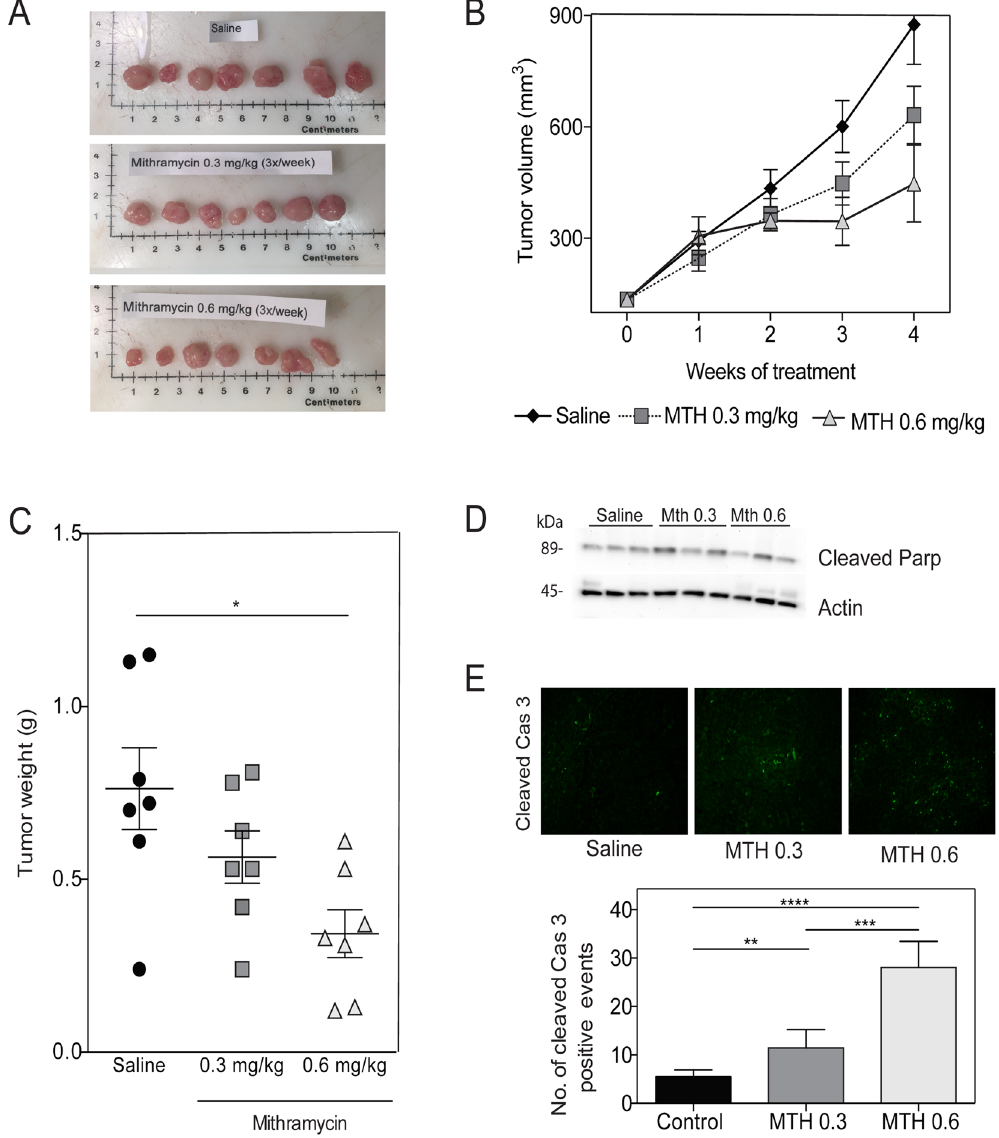
Figure 1. Sp1 downregulation causes tumor regression. MIA PaCa-2 cells injected subcutaneously, and treated with saline or mithramycin for 4 weeks. ( A ) Tumors explanted from saline, mithramycin 0.3 mg/kg, and mithramycin 0.6 mg/kg ( B ) Tumor volume ( C ) Tumor weights ( D ) Tumors analyzed for apoptosis with cleaved PARP by western blot, and ( E ) cleaved caspase 3 by